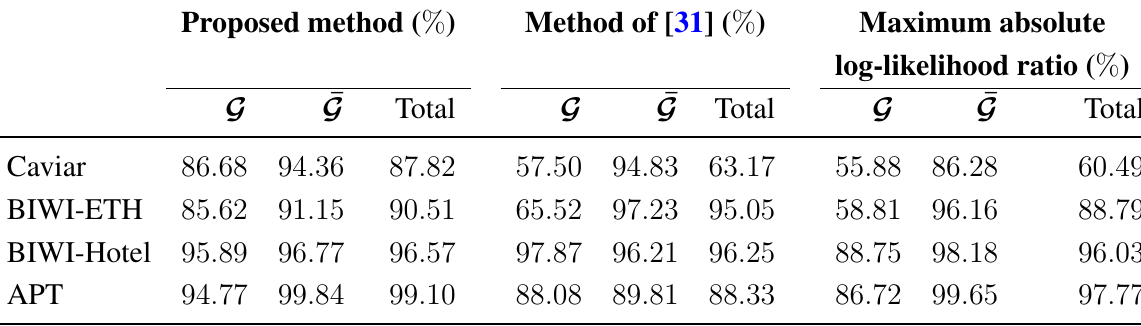
Table 5. Performance comparison of the proposed method to the method of [31] and method of maximum absolute log-likelihood